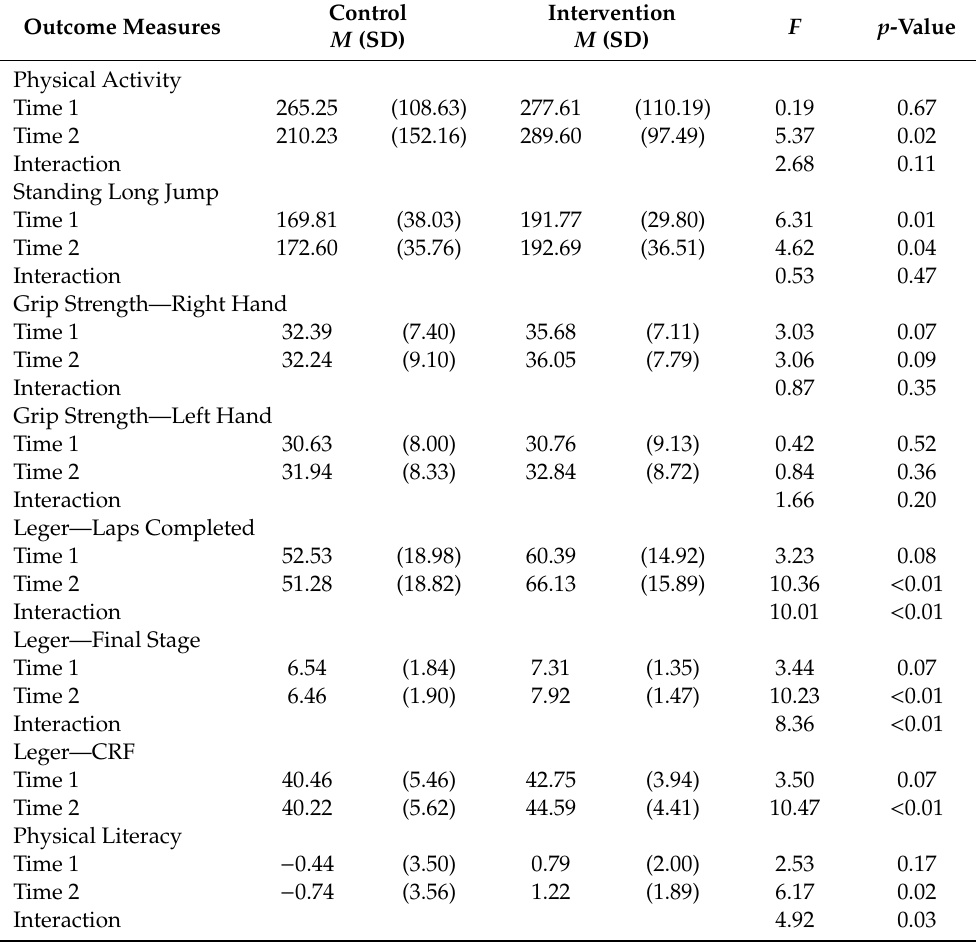
Table 2. Comparison of Physical Activity and Physical Fitness Scores by